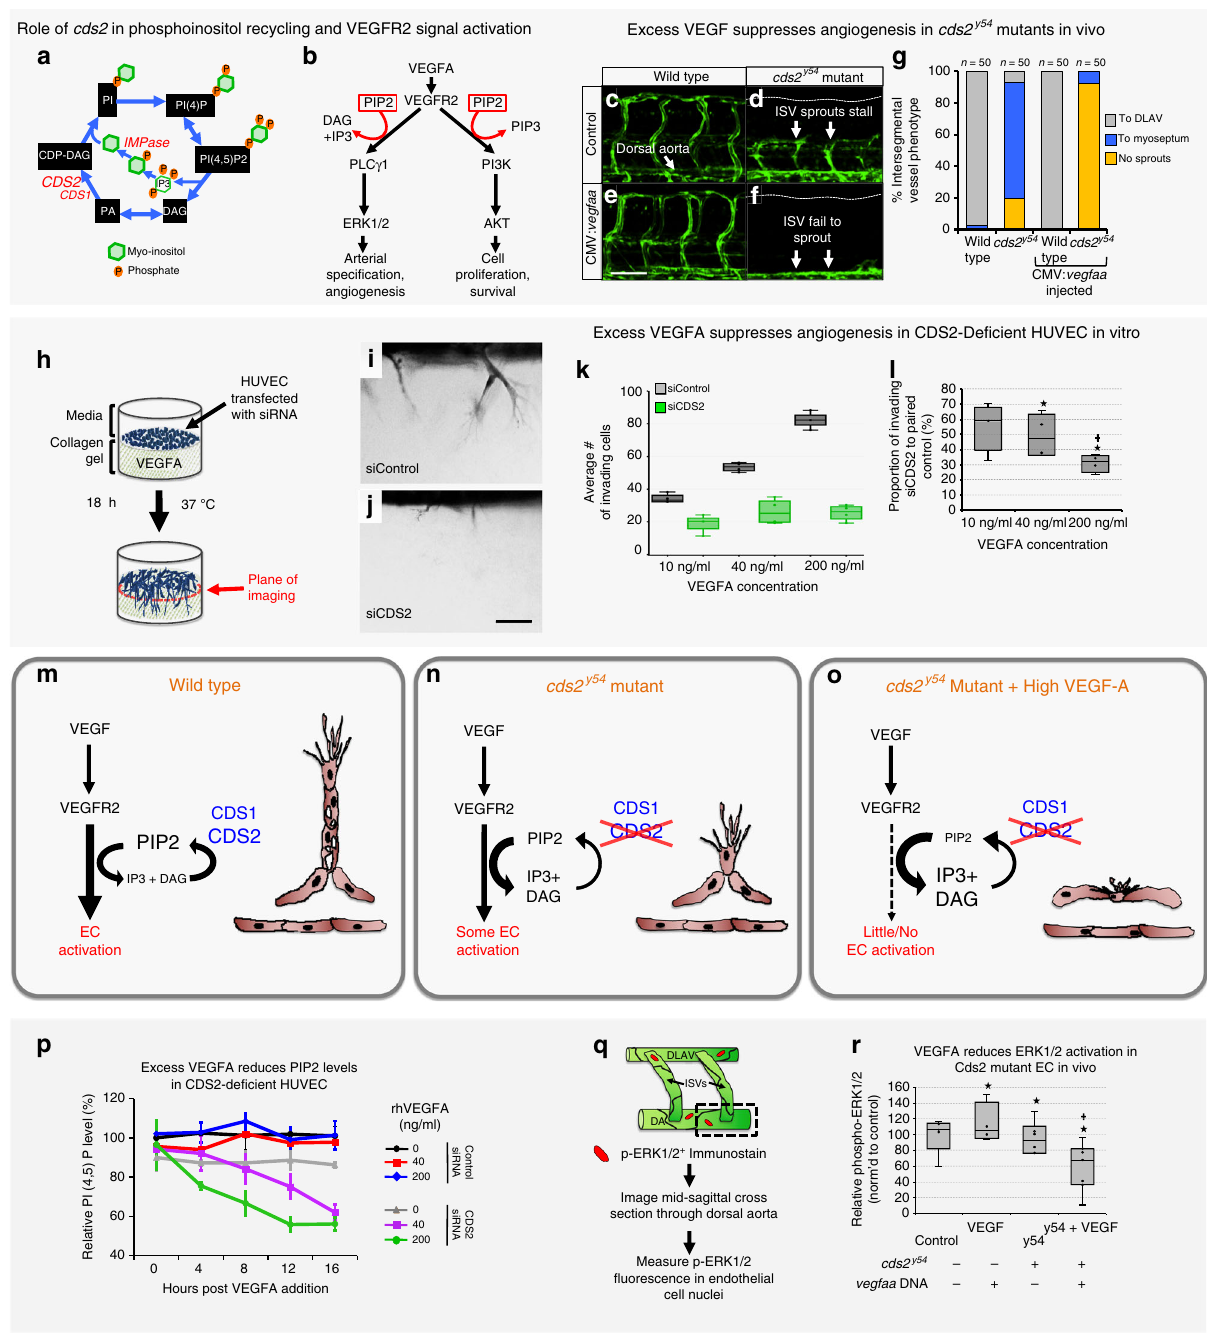
We further examined whether zebra fi sh vessels and HUVECs show increased sensitivity to VEGFA when inhibiting PI4K2A, PI4K2B, and PIP5K1C — the kinases that directly phosphorylate PI to generate PI(4,5)P2 (Supplementary Fig. 7) 9 – 11 . As with cds2 y54 mutants, injecting exogenous CMV :vegfaa in zebra fi sh treated with PI4K inhibitor exacerbates the angiogenesis defects noted (Supplementary Fig. 7A – G). VEGF-promoted anti-angiogenic phenotypes are also recapitulated in HUVECs in which either PI4K2B or PIP5K1C are suppressed using siRNA (Supplementary Fig. 7H, I). Suppression of PI4K2B or PIP5K1C sensitizes HUVEC to exogenously supplied VEGFA, with in vitro angiogenesis reduced to a greater extent as VEGF concentration is increased (Supplementary Fig. 7H, I). Suppression of PI4K2A did not cause NATURE COMMUNICATIONS| (2020) 11:1204